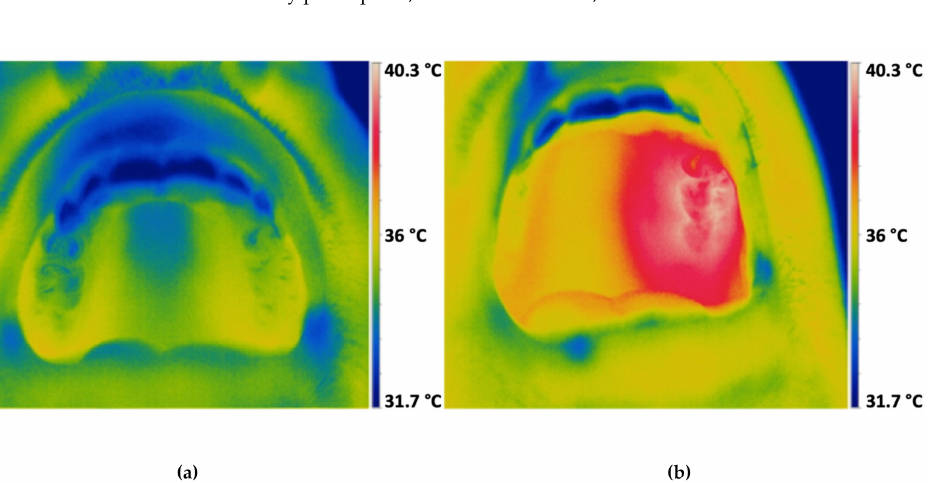
Figure 2. Images taken by thermographic camera before and after VIS + wIRA treatment: ( a ) infrared image taken before VIS + wIRA treatment; ( b ) infrared image taken after 20 min of VIS + wIRA